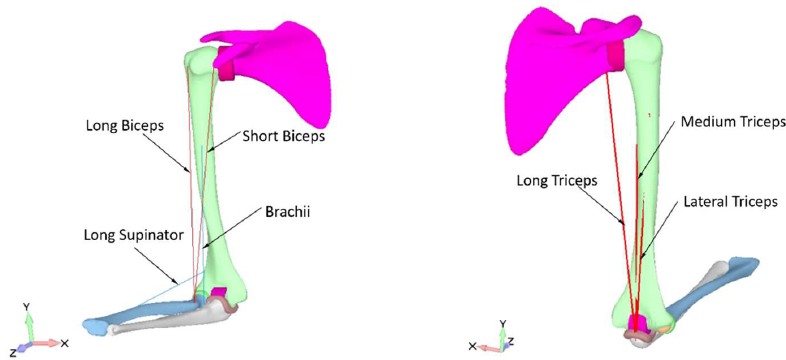
Figure 2. FEA model, muscles identification, flexors ( left ) and extensors ( right ).